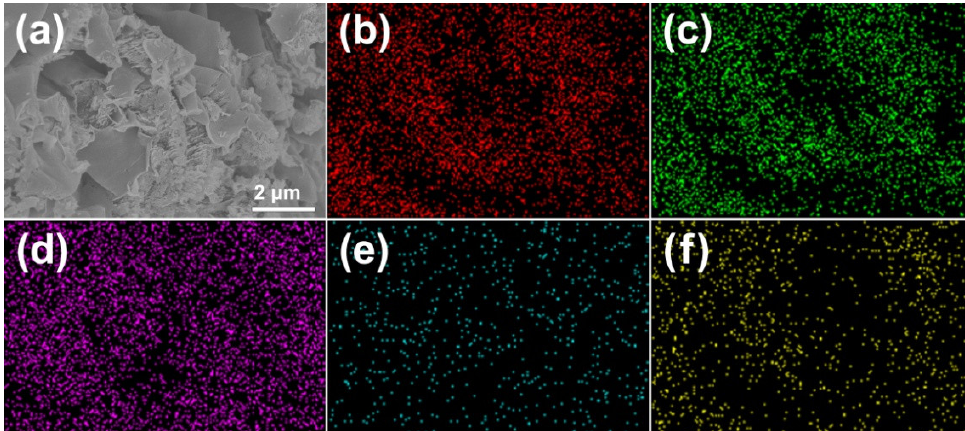
Figure 2. ( a ) SEMand element mapping images of ( b ) C, ( c ) N, ( d ) Eu, ( e ) V, and ( f ) O of EVC-2.